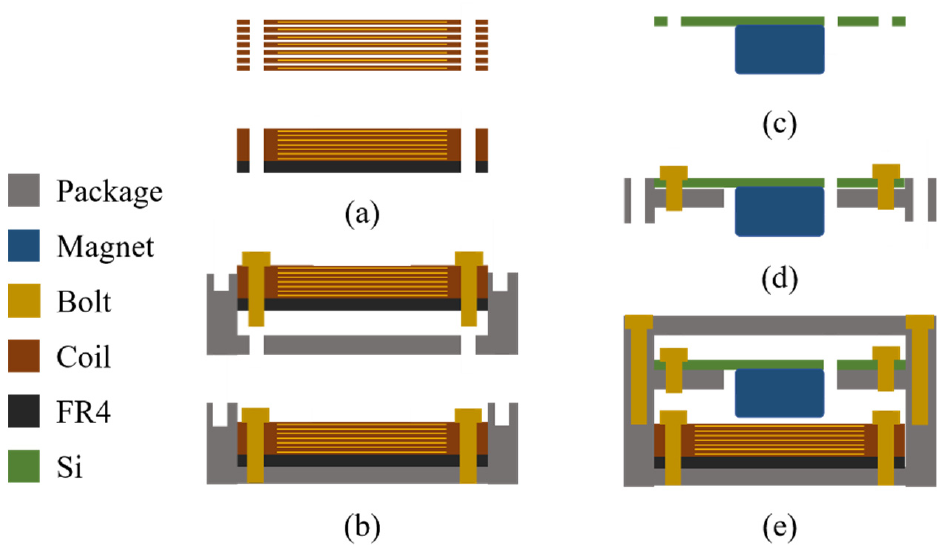
Figure 5. Assembly process of: ( a ) the stacked flexible coils; ( b ) the bottom package; ( c ) the magnet and device layer; ( d ) the intermediate package; ( e ) the package top cover.